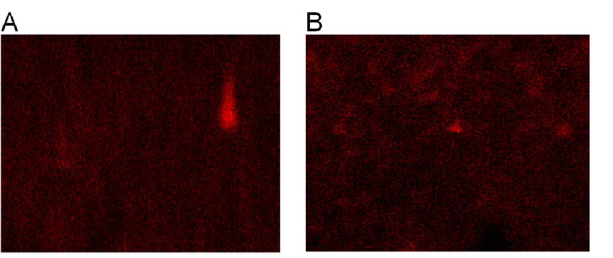
Figure 8. X-ray diffraction of oxo-biodegradable plastic before exposure to sunlight (A) and after 120 days of sunlight and 90 days of incubation. The small red points represent titanium.